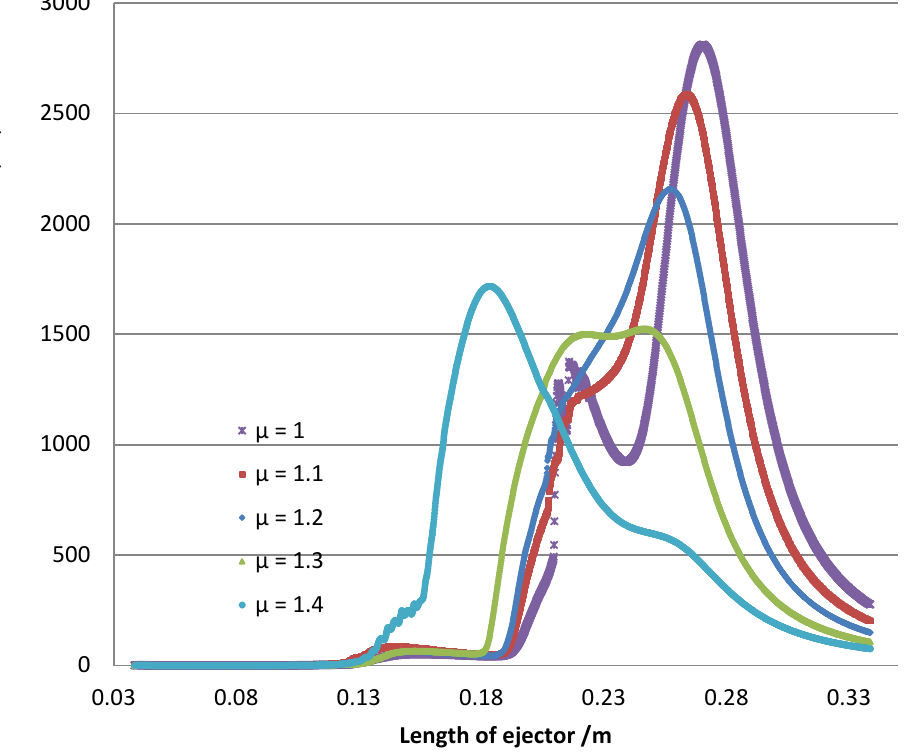
Fig. 4. : Turbulence kinetic energy along axis at different pressure